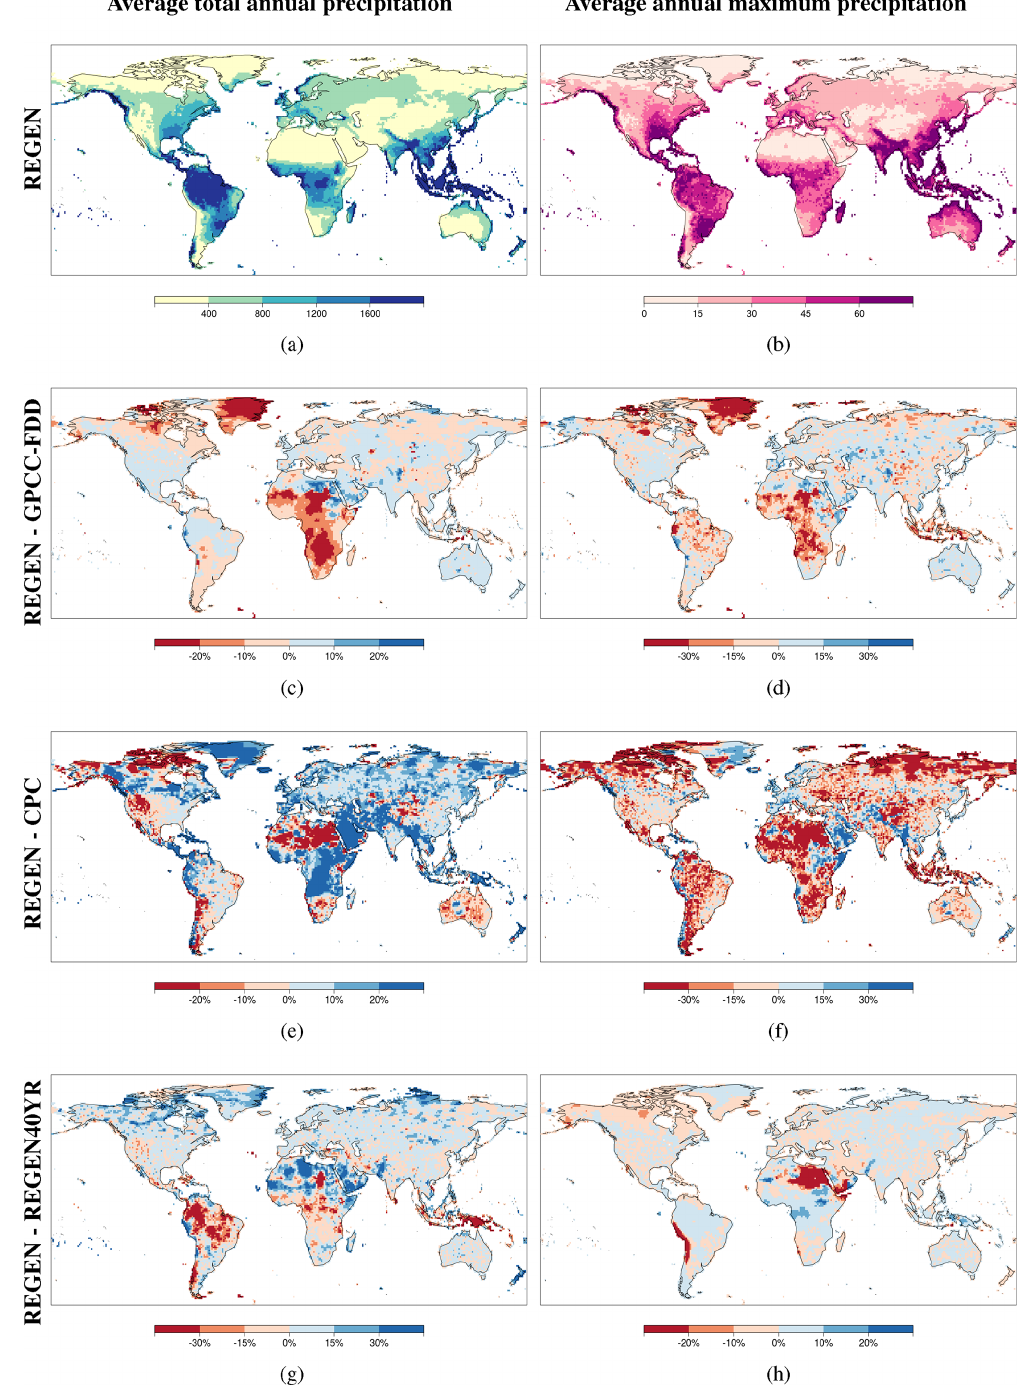
Figure 10. Percentage difference in averaged total annual precipitation (c, e, g) and averaged maximum annual precipitation (d, f, h) between REGEN and GPCC (c, d) , REGEN and CPC (e, f) , and REGEN and REGEN40YR (g, h) data. The first row shows the absolute values of total annual precipitation (a) and annual maxima (b) averaged over 1988–2013 (the longest common time period between the three